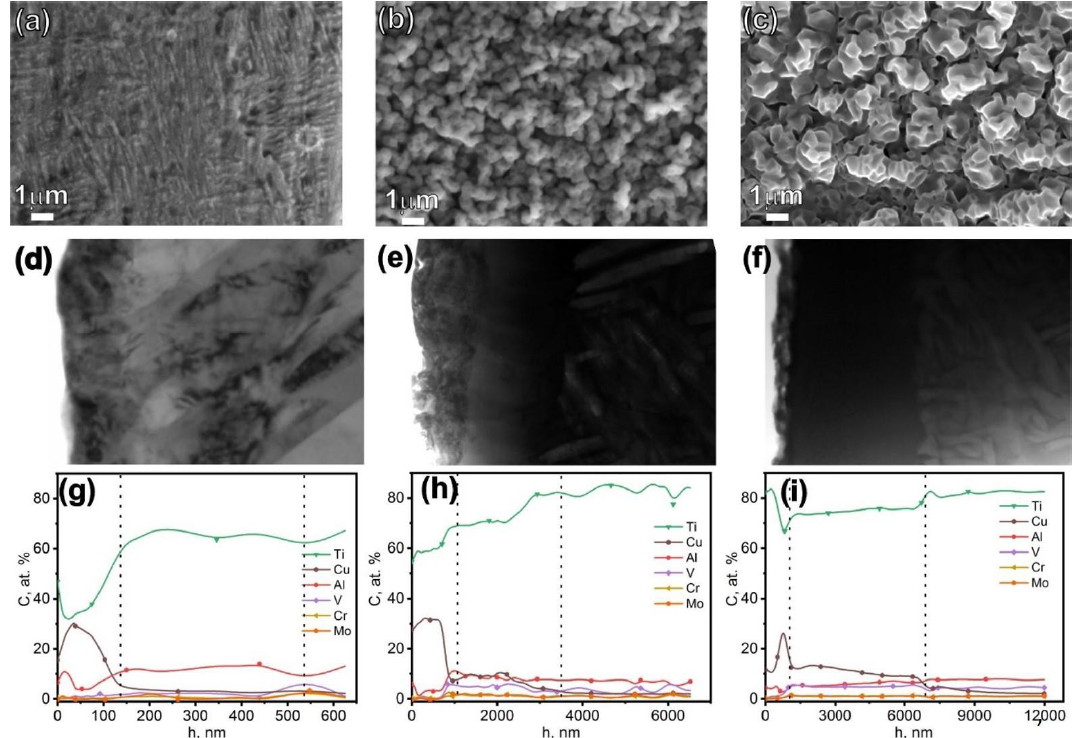
Figure 2. Surface morphology of the treated titanium alloy: 3 min ( a ), 6 min ( b ), 7.5 min ( c ). TEM images of the cross-section of the titanium alloy modified with copper ions with different processing times ( d – f ) and the distribution of the elements in depth: the processing time is 3 min ( g ), 6 min ( h ), 7.5 min ( i ).